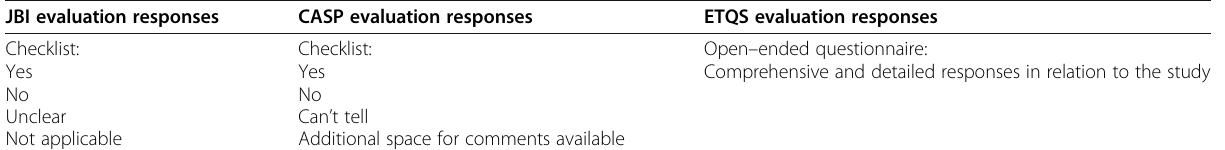
Table 10 Recommended reviewer responses to JBI (Joanna Briggs Institute), CASP (Critical Appraisal Skills Program) and ETQS (Evaluation Tool for Qualitative